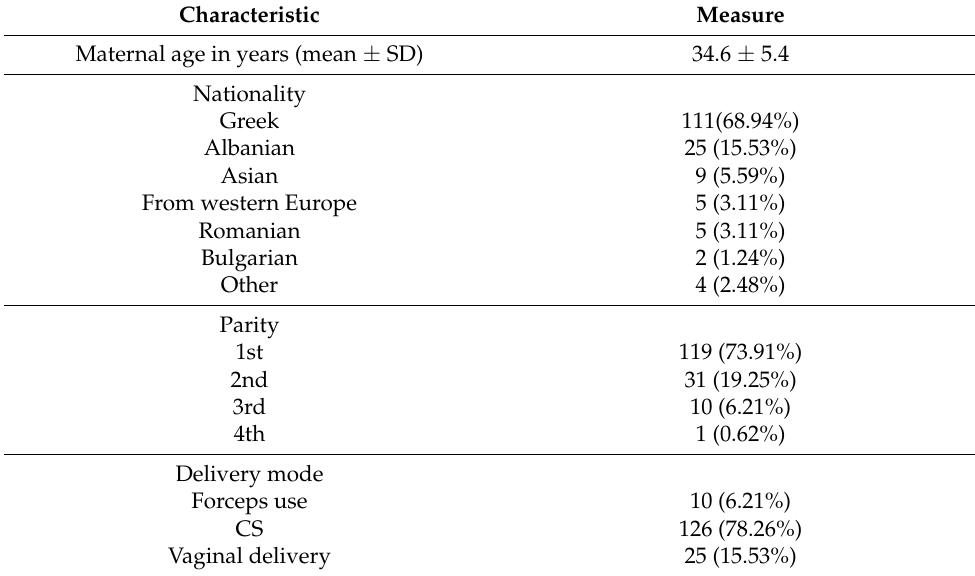
Table 1. Baseline characteristics of the